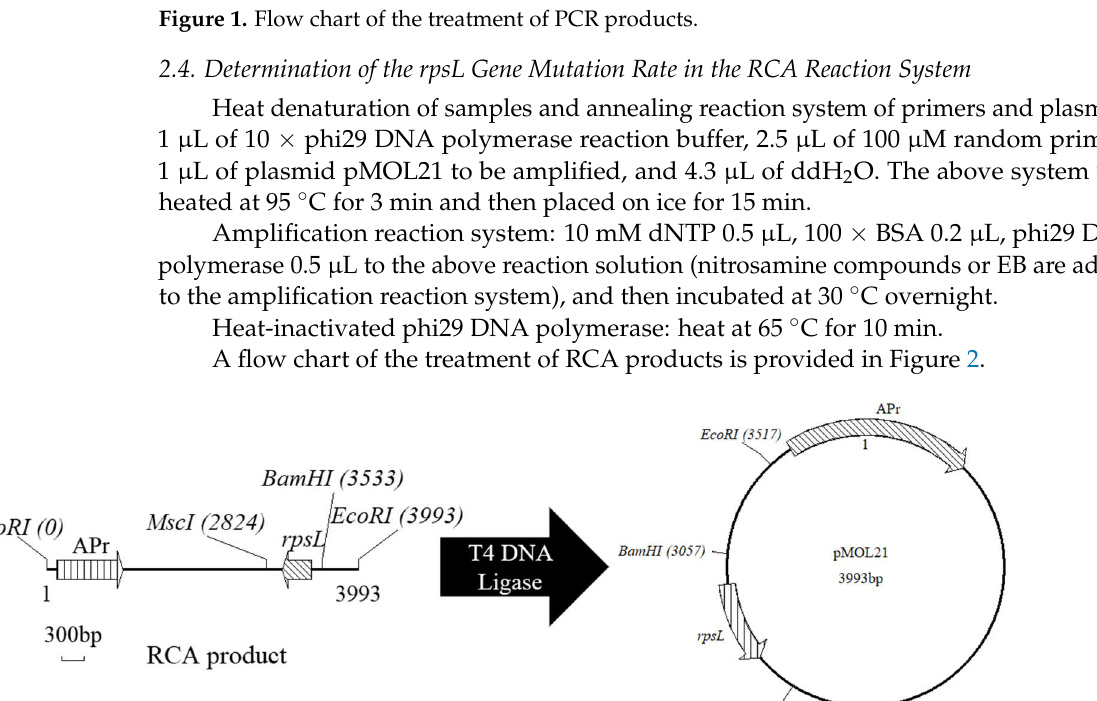
Figure 1. Flow chart of the treatment of PCR products.